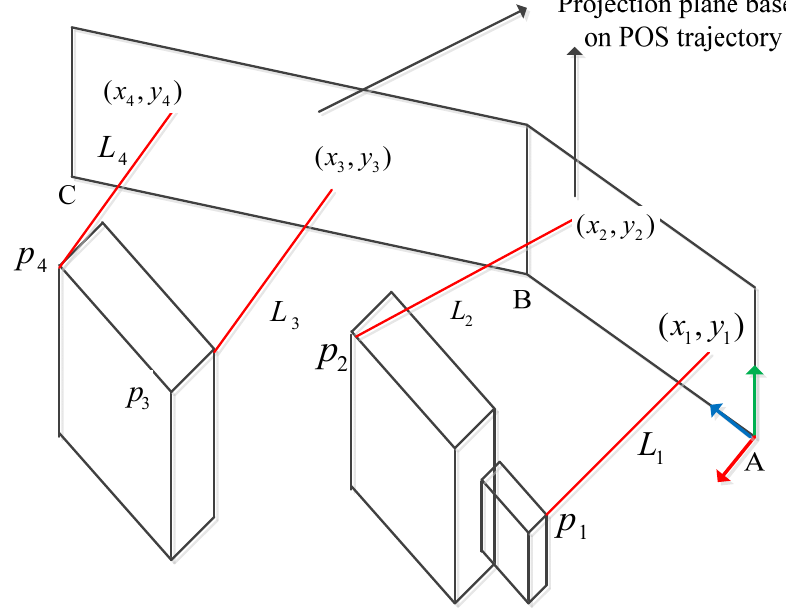
Figure 3. Point cloud facade projection based on position and orientation system (POS) trajectory.